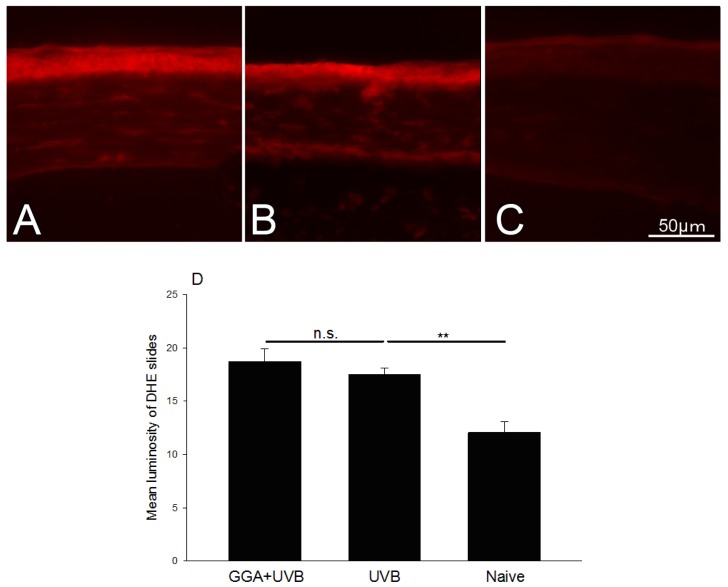
Reactive oxygen species (ROS) signal expression after UVB exposure. (A) Eyes of mice treated with 500 mg/kg GGA and irradiated at a dose of 400 mJ/cm2. (B) Eyes not treated with GGA and irradiated at a dose of 400 mJ/cm2. (C) Naive corneas. (D) Mean gray values of the corneal epithelium of DHE stained slides. **p < 0.01; n.s. p > 0.05 (Mann-Whitney U-Test).